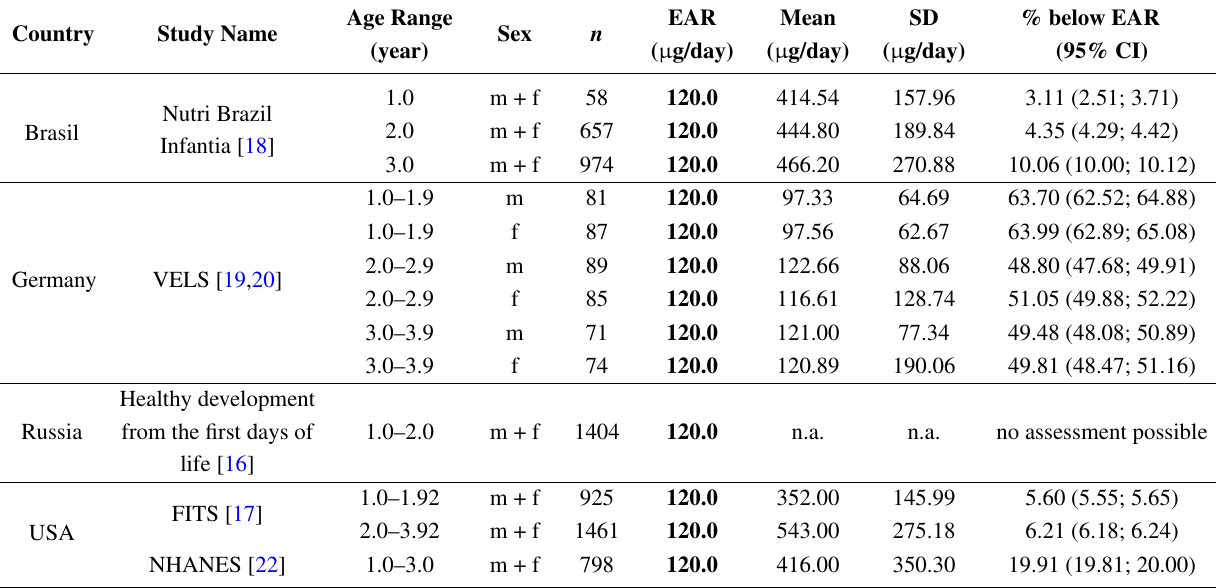
Table 6. Mean folate intake ( µ g/day) and prevalence of inadequate intake (% below EAR) in Brazil, Germany, Russia and the United States.